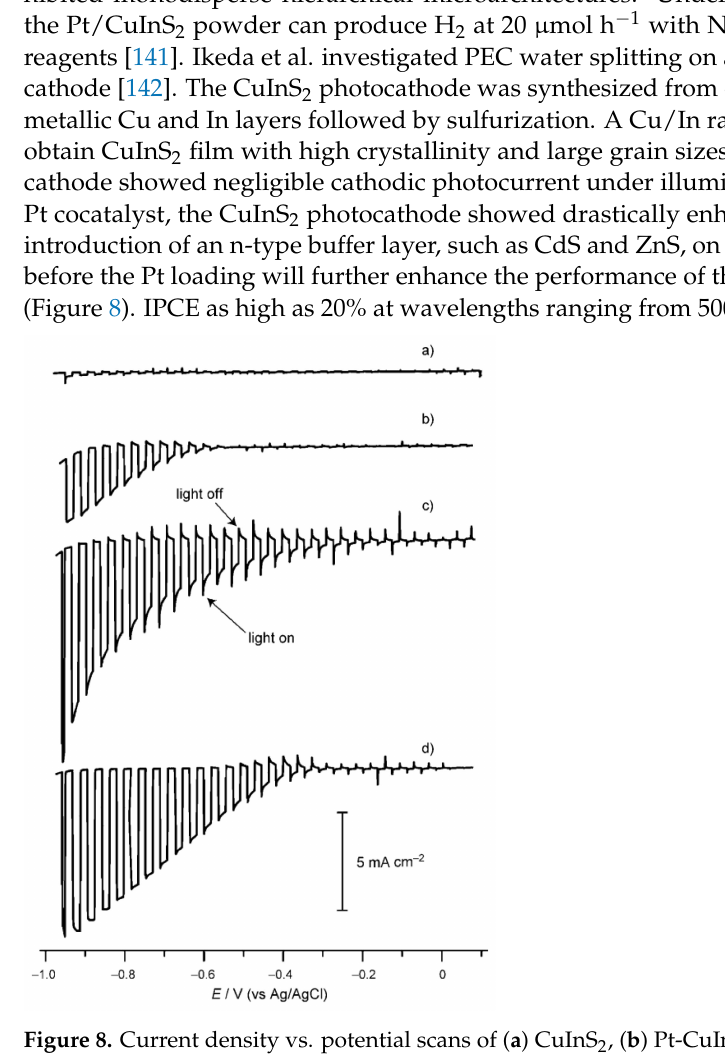
Figure 8. Current density vs. potential scans of ( a ) CuInS 2 , ( b ) Pt-CuInS 2 , ( c ) Pt-CdS/CuInS 2 , and ( d ) Pt-ZnS/CuInS 2 in a Na 2 SO 4 solution with pH adjusted to 4 under chopped illumination